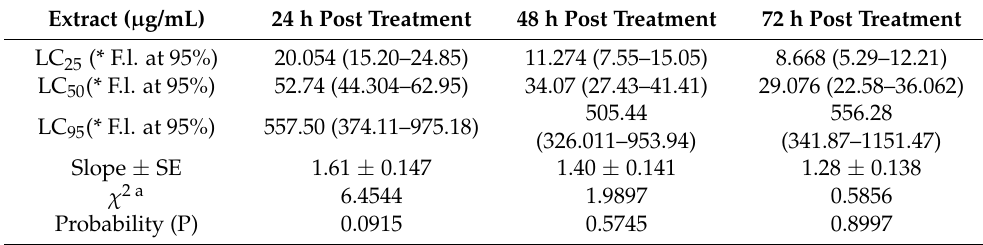
Table 2. Larvicidal activity of L. coronopifolia extract against the 3rd instar larvae of Culex pipiens 24, 48, and 72 h post